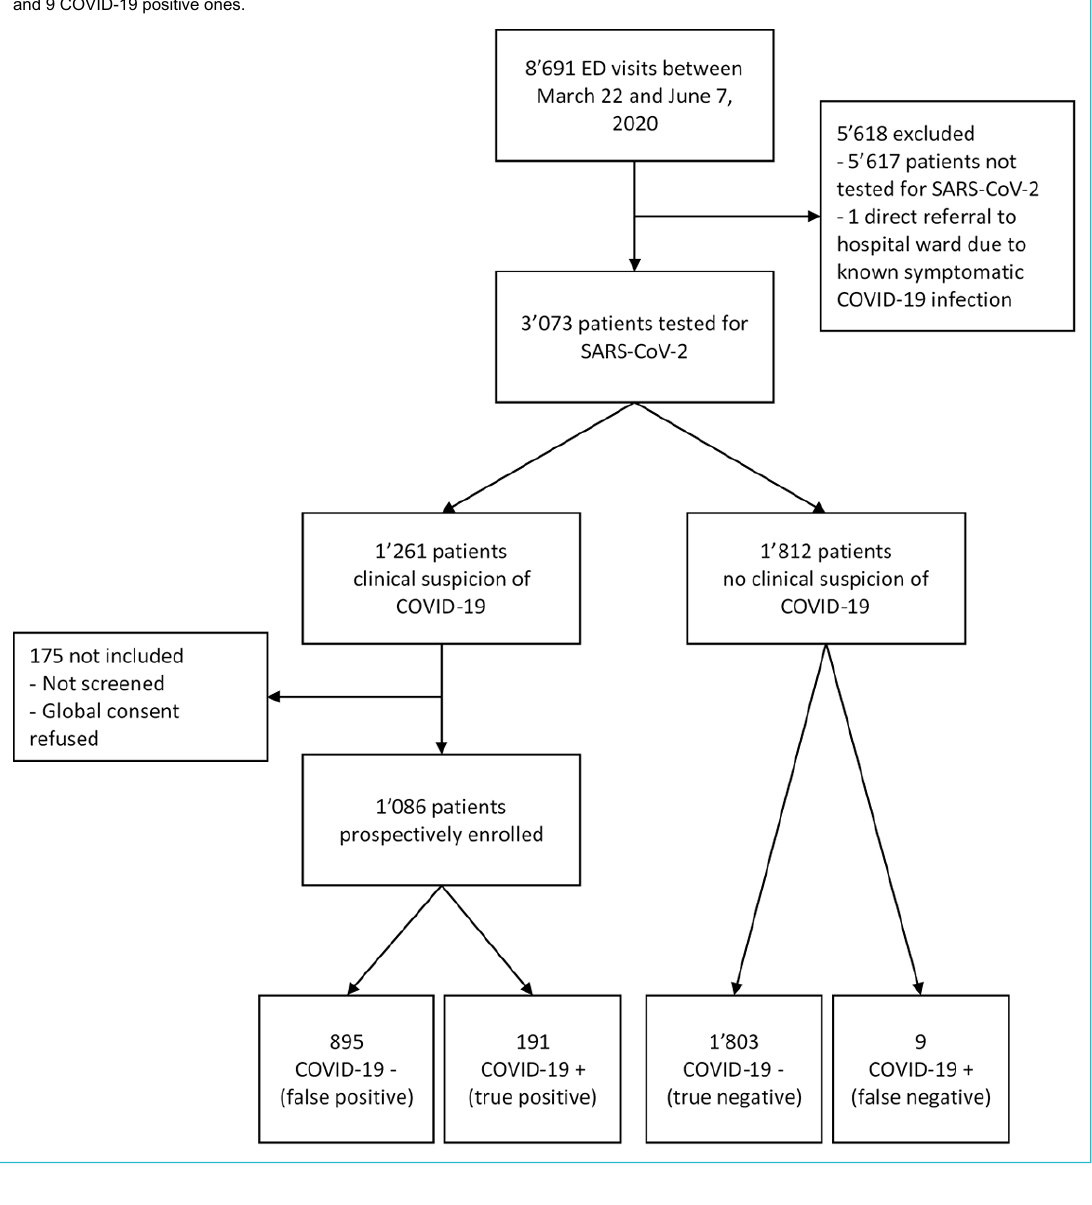
Figure 1: Flow of patient inclusion. Out of 8691 emergency department (ED) patients during the study period, 3074 were tested for SARS- CoV-2, of whom 176 patients were excluded. The final study population included 1086 patients suspected of COVID-19, consisting of 895